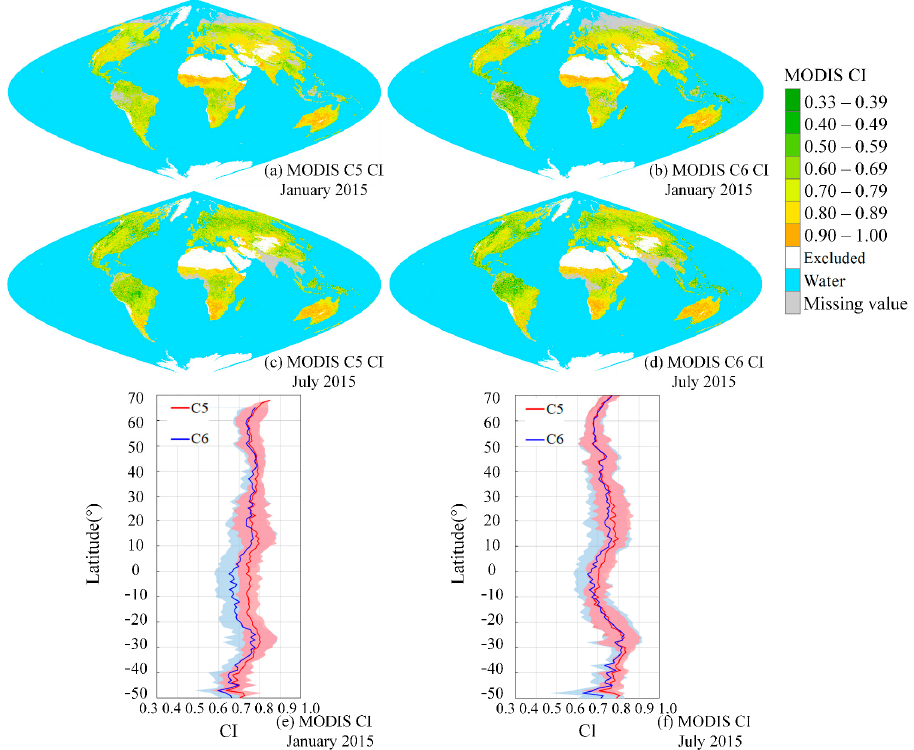
Figure 3. Global distribution of CI retrieved from MODIS C5 and C6 MCD43 products in January and July 2015. Panels ( a – d ) are color ‐ coded global maps of the MODIS C6 and C5 CIs. The sinusoidal projection is used here. Panels ( e ) and ( f ) show the latitudinal distribution of the MODIS C5 and C6 CIs, respectively. The red and blue lines indicate C5 and C6 CIs, respectively, and the corresponding shaded area indicates the one standard deviation range.